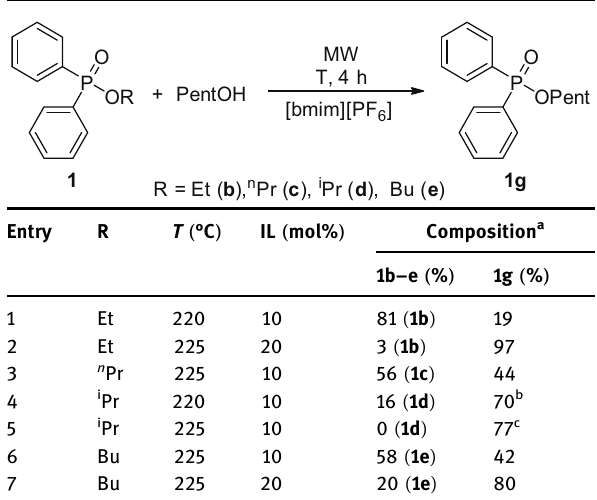
Table 7: Alcoholysis of alkyl diphenylphosphinates with pentanol under MW conditions in the presence of [ bmim ][ PF 6 ] as the catalyst